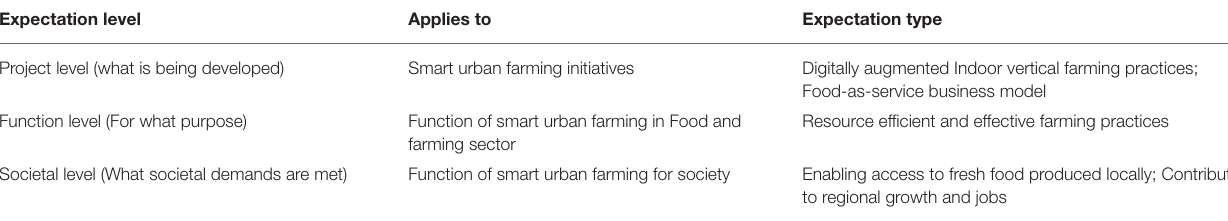
TABLE 2 | Expectations of smart urban